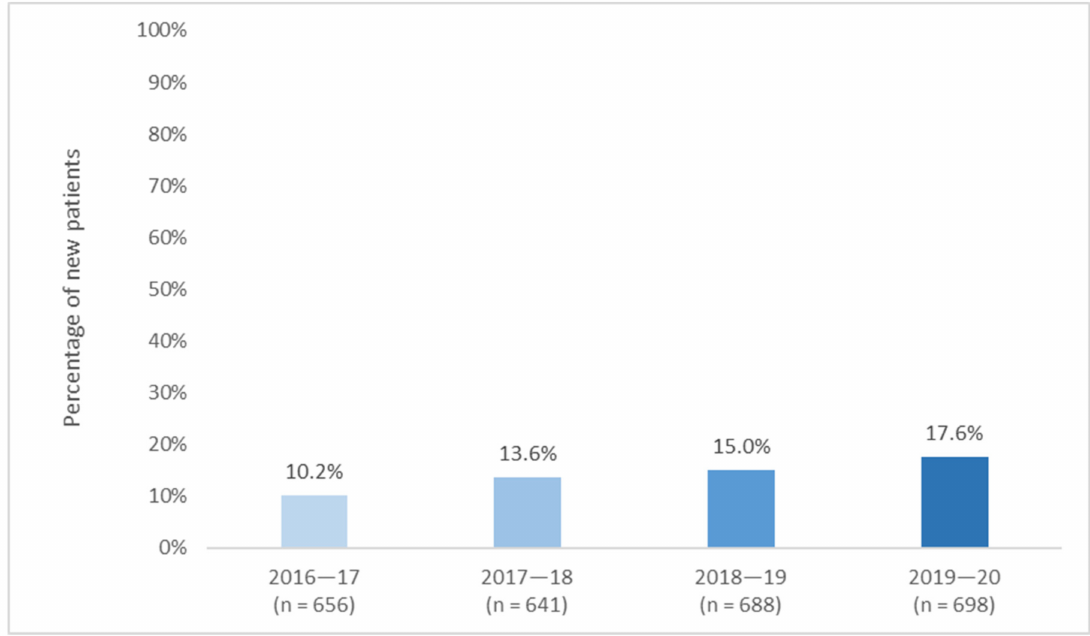
Figure 1. YCS activity data on medical clinical trial enrolment, 2016–17 to